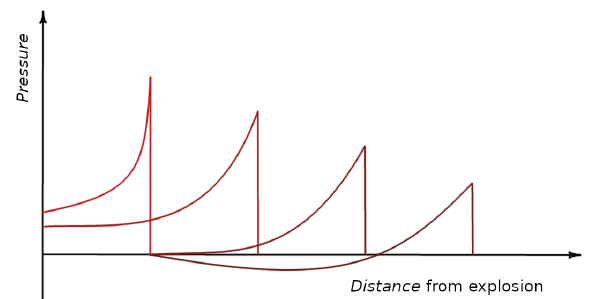
Figure 3. Blast pressure as a function of distance at four points in time, reproduced according to (Ngo et al., 2007).